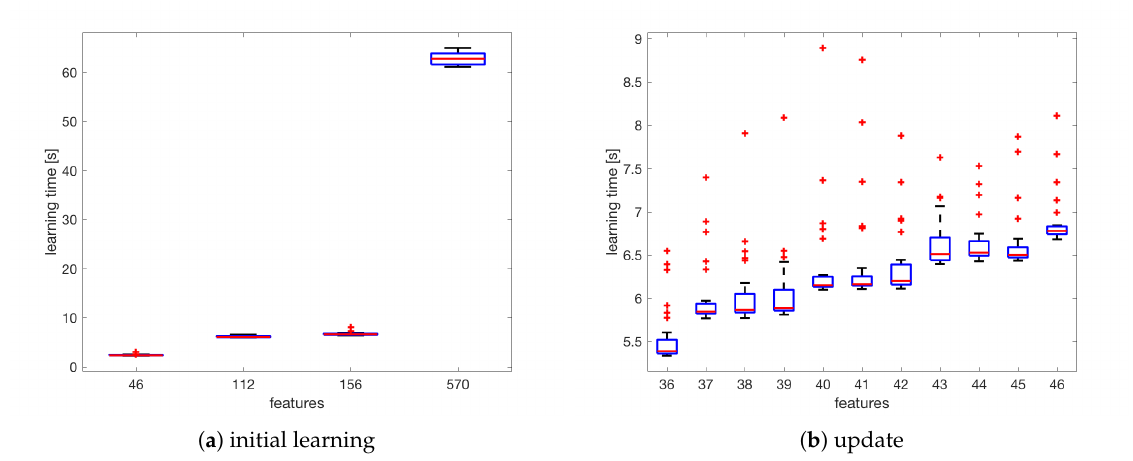
Figure 10. Learning time calculated for a various number of